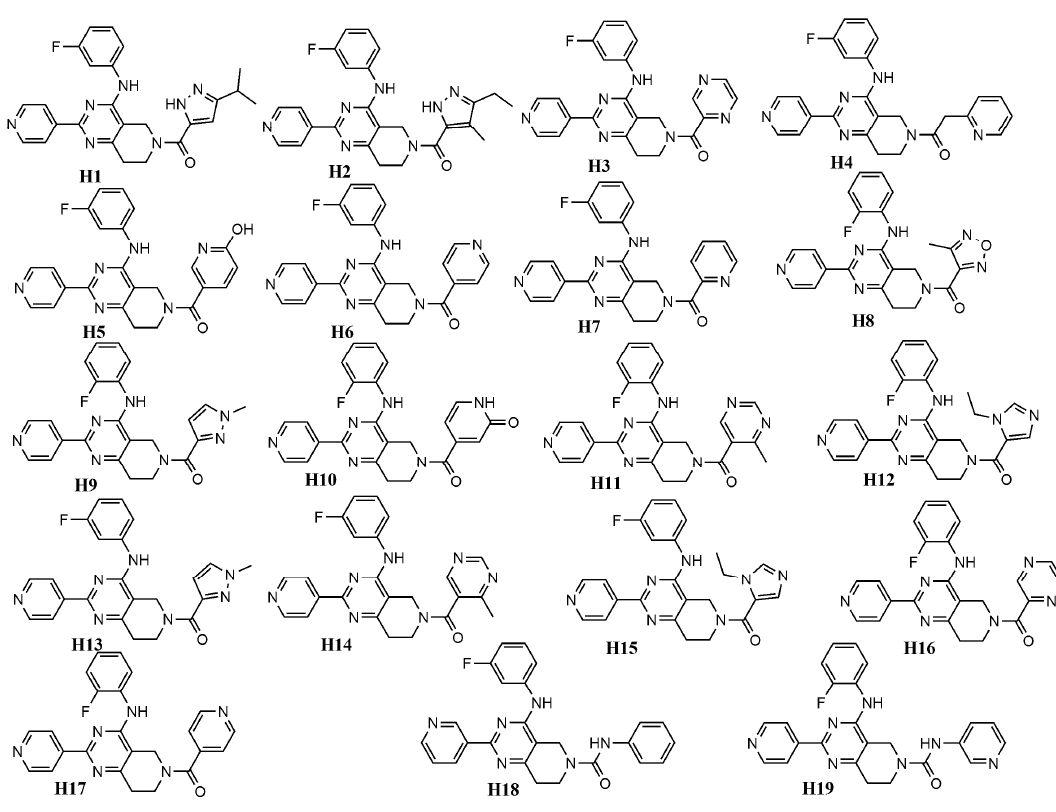
Figure 6. Chemical structures of virtual hits ( H1 – H19 ) for ERK-1/2 inhibition.